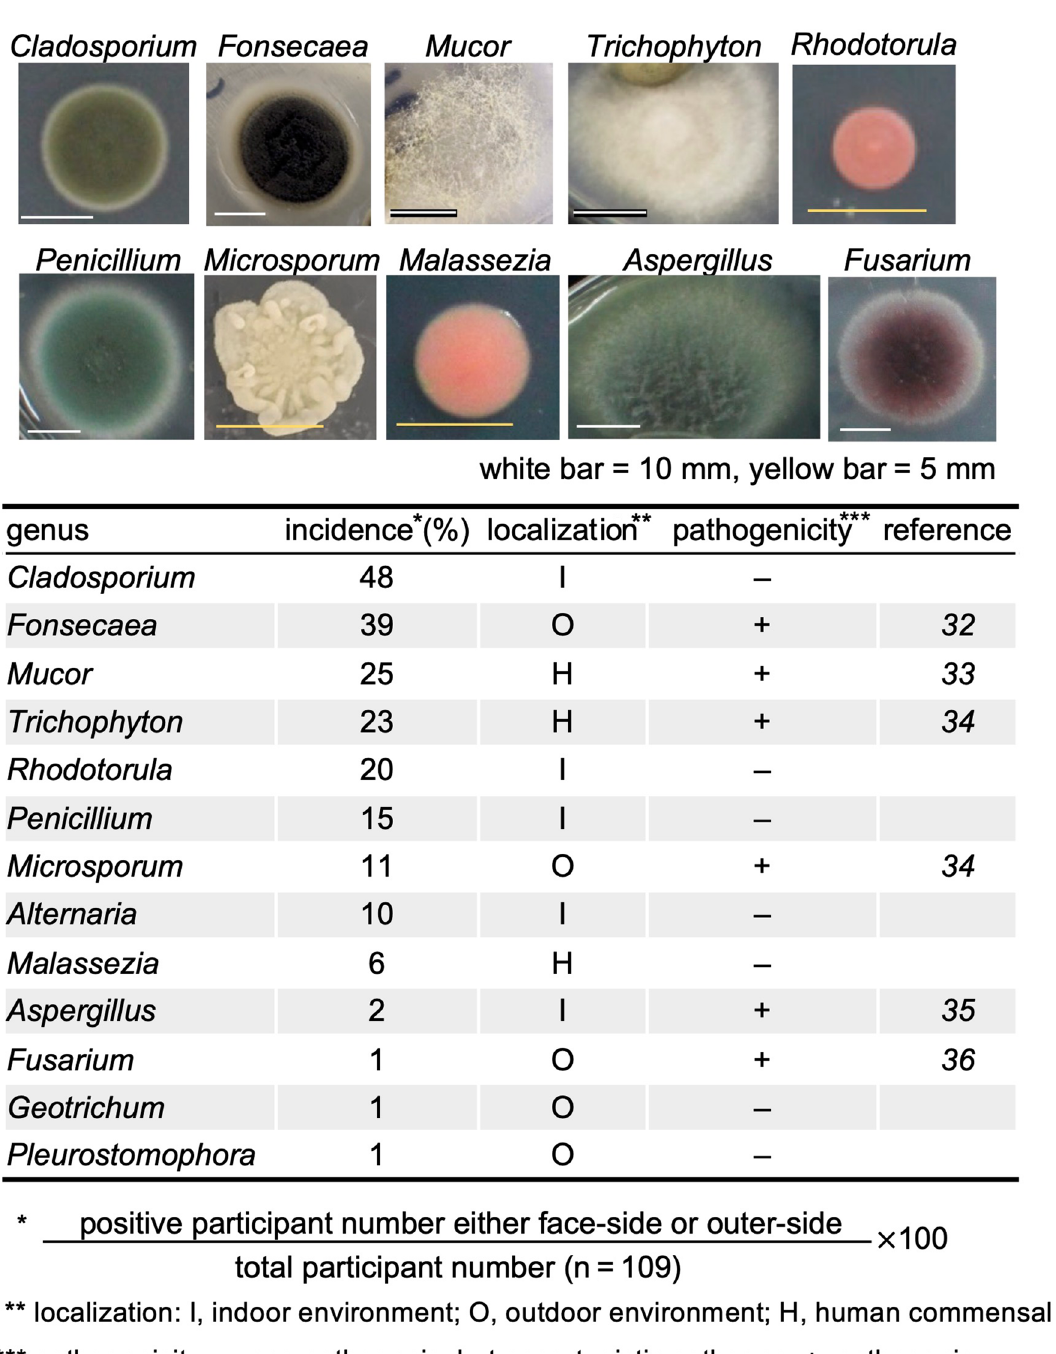
Figure 5. Identification of fungal colonies. We identified fungi by the colony morphology macroscopically as well as the hypha and spore morphology microscopically. Ten representative fungal images were shown. The white and yellow bars are 10 mm and 5 mm, respectively. Identified fungi, the incidence in this study, localization, and pathogenicity were